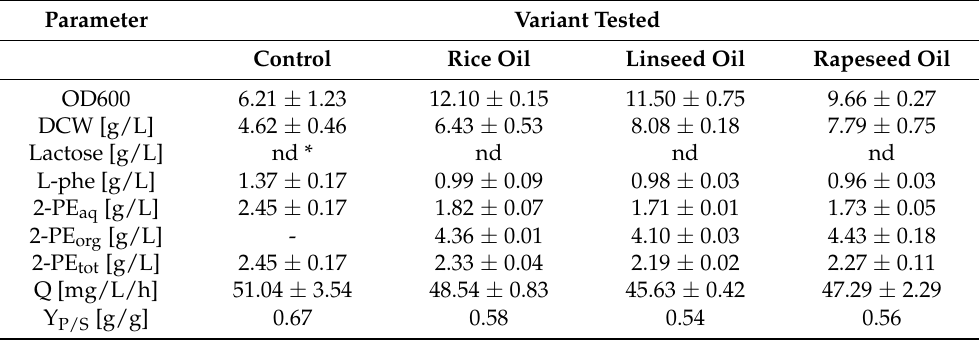
sults are summarised in Table 1. Table 1. Parameters of 48 h two-phase batch cultures of K. marxianus WUT240 in WP25 medium at 30 °C. Analyses were performed in triplicate and data are presented as the mean ± SD. Parameter